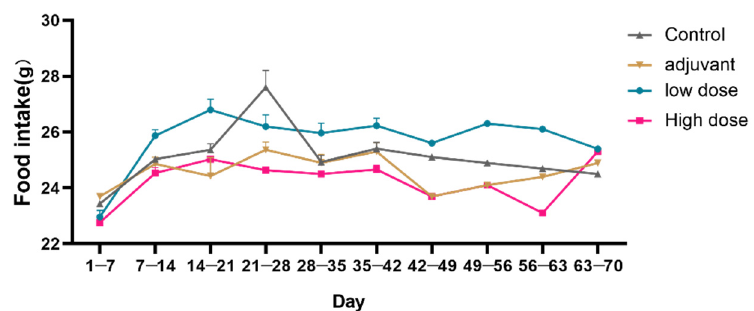
Figure 2. Food intake per animal. Values are the average ± SEM of animals in each group. Levene’s test p ≥ 0.05. The feed addition and feed surplus per cage per week were recorded to calculate the average daily feed intake of each animal, expressed in “g/animal/day”.